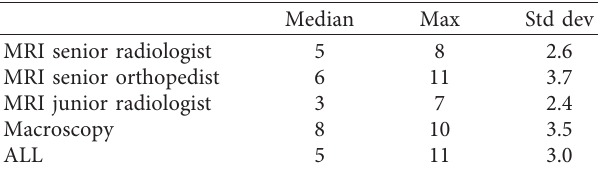
Table 7: Reliability with PSI (in mm) without patient 5.